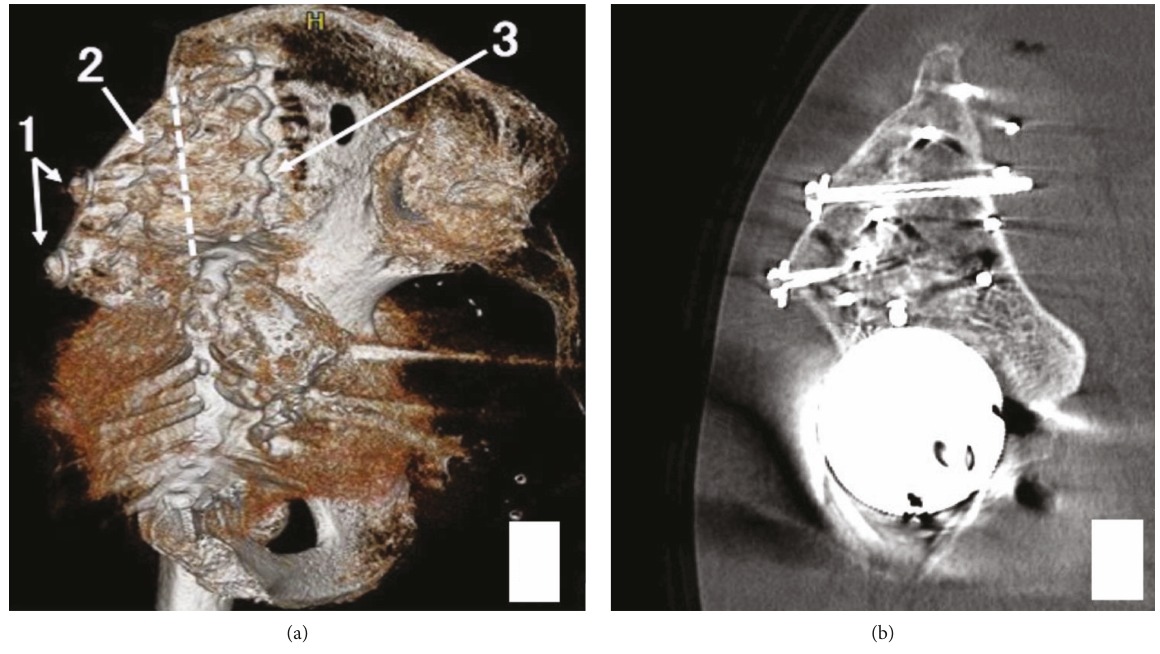
Figure 4: Reconstructed computed tomographic image (a). The dotted line indicates the osteotomy line of the iliac bone. The slid bone is fi xed by two screws (1) and a small plate (2), and (3) indicates the reconstruction plate. Cross-sectional computed tomographic image